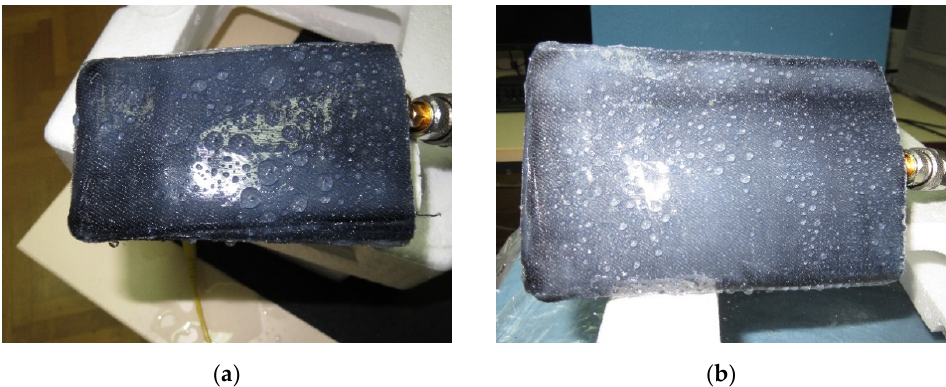
Figure 15. Water droplets formed on the protective silicone-sealant-coated denim pouch: ( a ) textile PIFA and ( b ) wideband monopole.